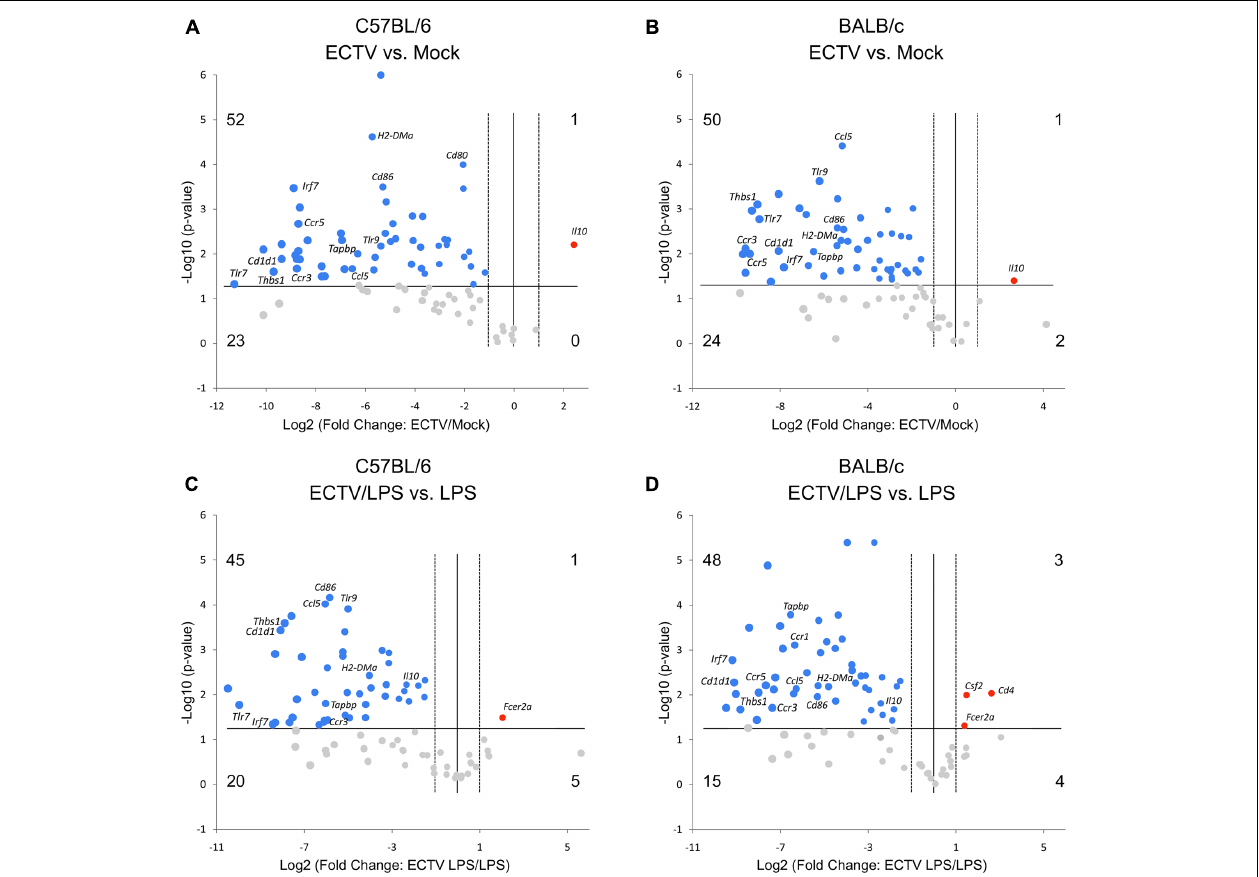
FIGURE 3 | ECTV similarly affects multiple genes involved in innate and adaptive immune functions in GM-BM from C57BL/6 and BALB/c mice. The volcano plots show differentially expressed genes in ECTV- vs. mock-infected GM-BM from C57BL/6 (A) and BALB/c (B) mice, and ECTV + LPS- vs. LPS-treated GM-BM from C57BL/6 (C) and BALB/c (D) mice. The volcano plots display the threshold for statistical significance (log10 of the P -value; horizontal line) and fold change (log2; vertical dotted lines). The two vertical dotted lines represent fold changes of –2 and +2, the horizontal line represents significant P -value of 0.05. The number of genes that are down(blue)- and up(red)-regulated by at least twofold and have a P -value less than 0.05 are at the upper-left and upper-right, respectively. The number of genes that are down- and up-regulated (gray) by at least twofold, however, have a P -value more than 0.05 are at the lower-left and lower-right,